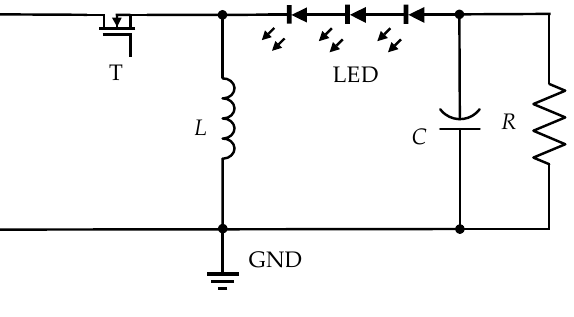
Figure 4. LED buck–boost converter.